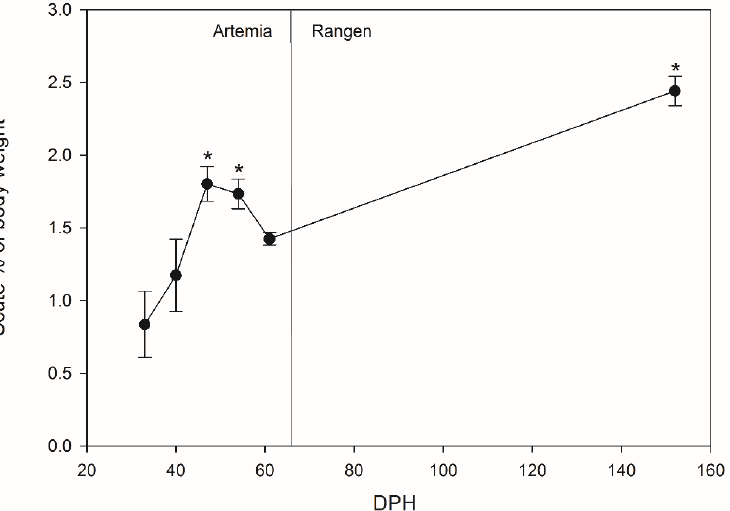
Figure 5. Scute mass as % of body weight in Lake Sturgeon at Warm Springs National Fish Hatch- ery (WSNFH) ( n = 10 – 12 per sample point). * indicates a significant difference between the sample point and 33 dph. Fish were fed live Artemia from 15 to 61 dph, and commercial chow (Rangen) from 62 to 152 dph. Kruskal – Wallis one-way ANOVA on Ranks: p < 0.0001.